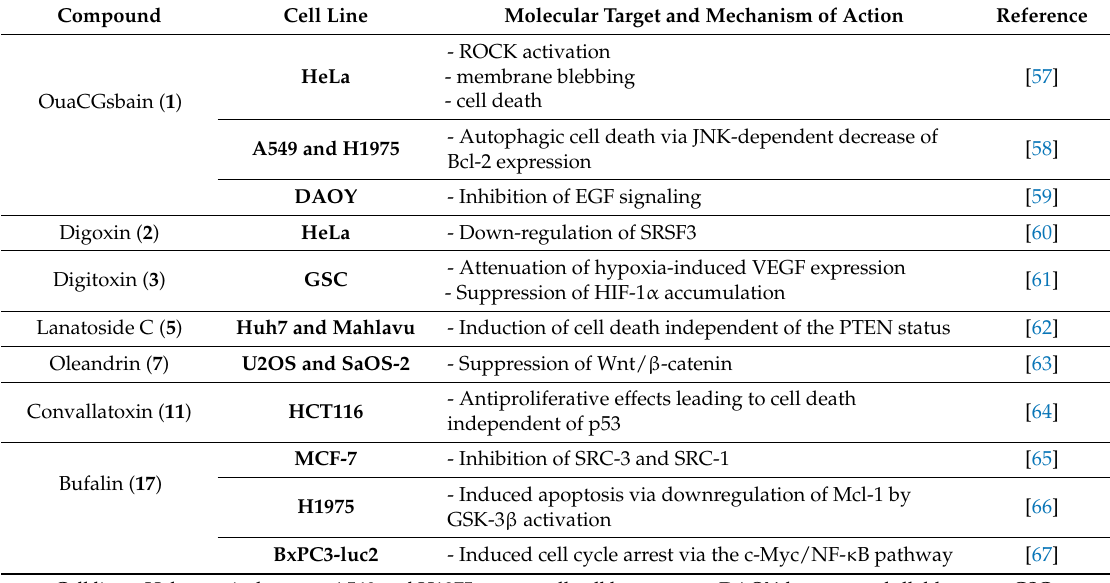
Table 1. In vitro CGs molecular target pathways in cancer